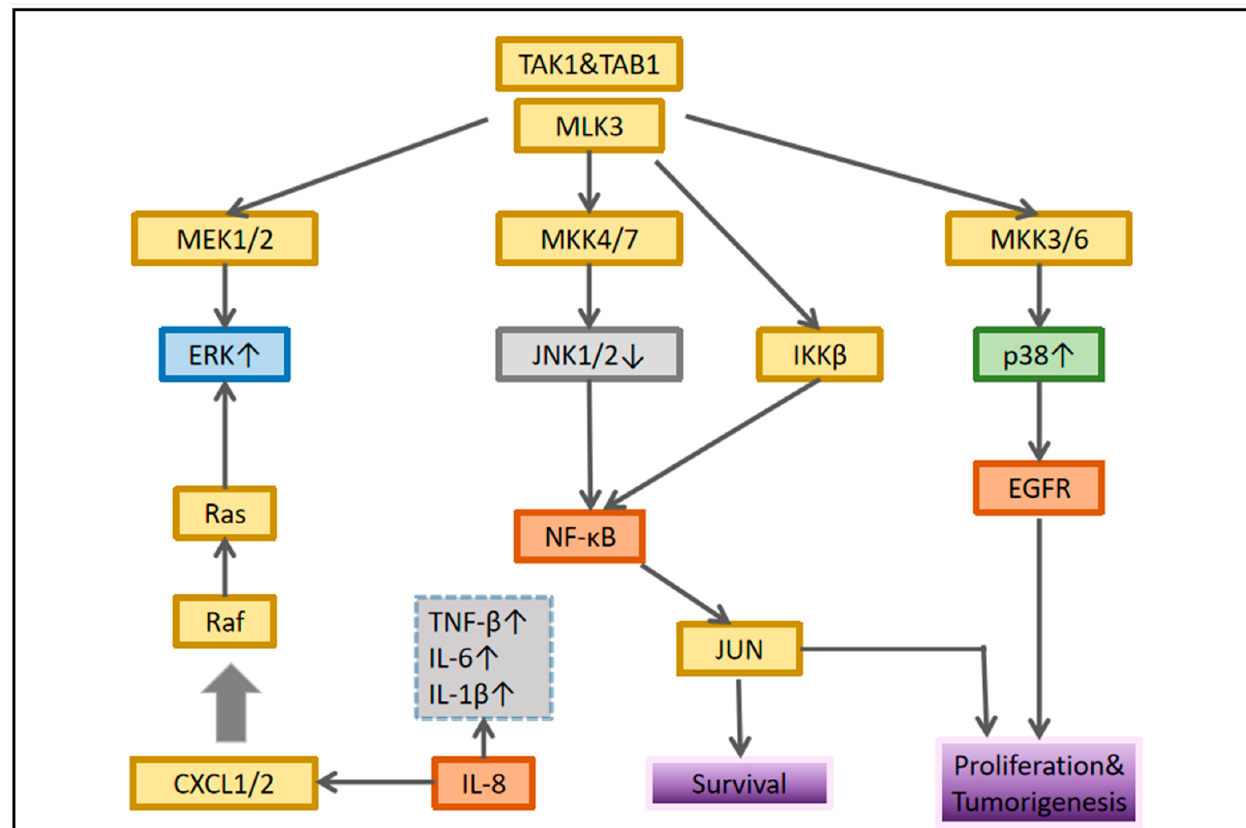
Figure 2. Interaction between MAPK and nuclear factor- κ B signaling. In each cellular system, different connections are established that determine the biological response of the tumor.